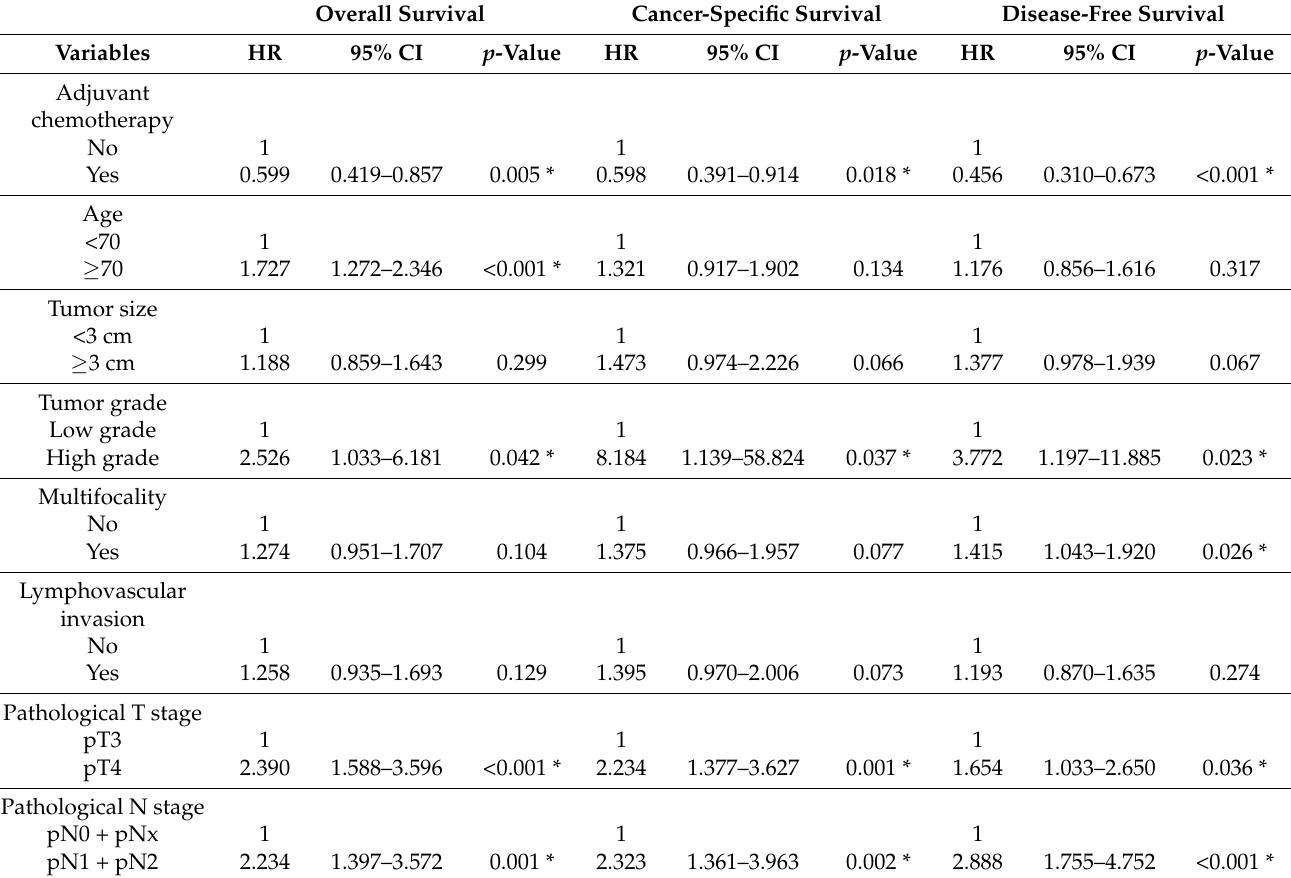
Table 3. Multivariate analyses for overall, cancer-specific, and disease-free survivals in advanced UTUC